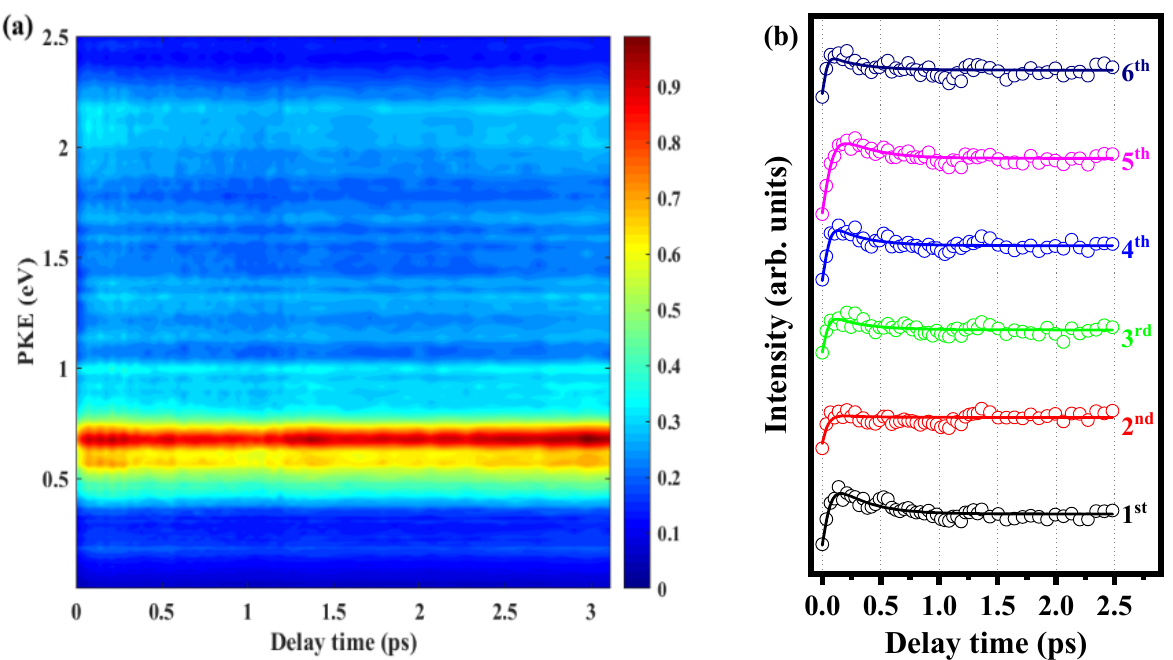
Figure 7. ( a ) Time ‐ resolved photoelectron spectrum obtained with 280 nm pump pulse and 800 nm probe pulse. ( b ) Signal intensities of the six peaks as functions of delay time. Experimental data are given as open circles, while solid lines are fitted results.